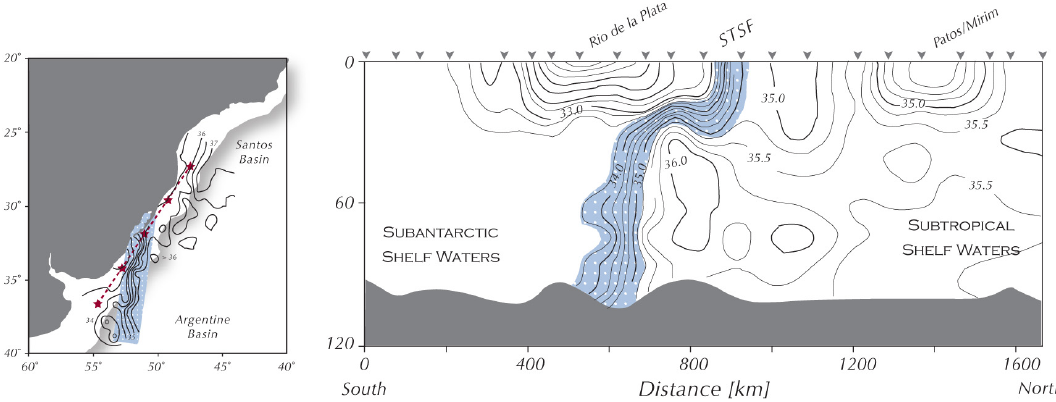
Fig. 12. Sea surface salinity (left panel) and alongshelf salinity transect (right panel). The stippled area marks the location of the STSF. Adapted from Piola et al. (2000).